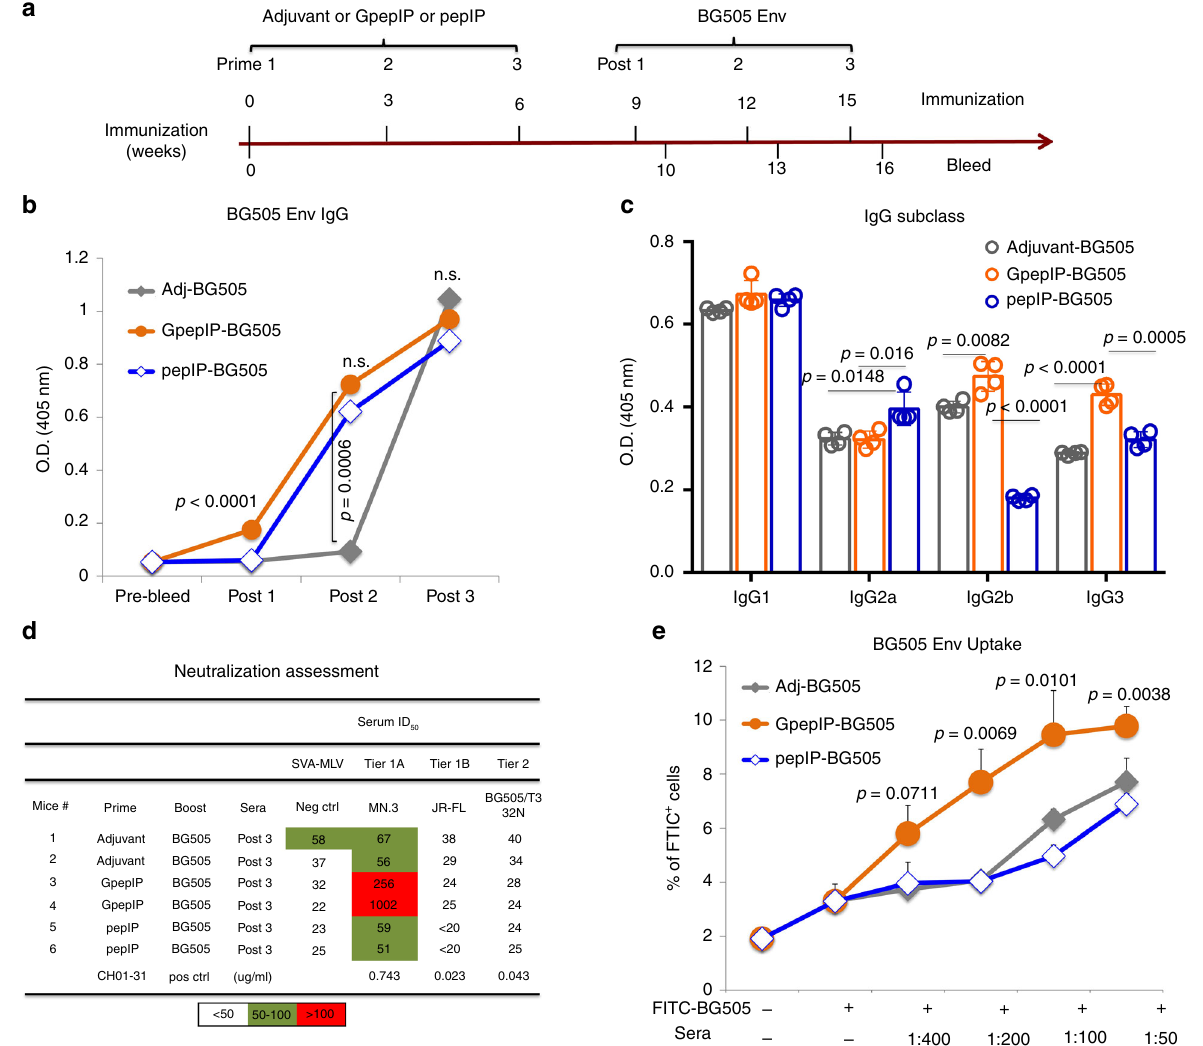
Fig. 7 GpepIP primary immunization prior to trimer immunization elicits functional antibody production. a Immunization scheme. BALB/c mice were primed three times (with a 3-week interval) by subcutaneous injection of GpepIP or pepIP emulsi fi ed in Freund ’ s adjuvant or of adjuvant alone. Subsequently, all groups were immunized with the clade A BG505 gp140 NFL trimer adjuvanted with Alum for three times (with a 3-week interval). Sera were collected 7 days after each trimer immunization (post 1 – 3). b BG505-speci fi c IgG production was examined in all three groups post each